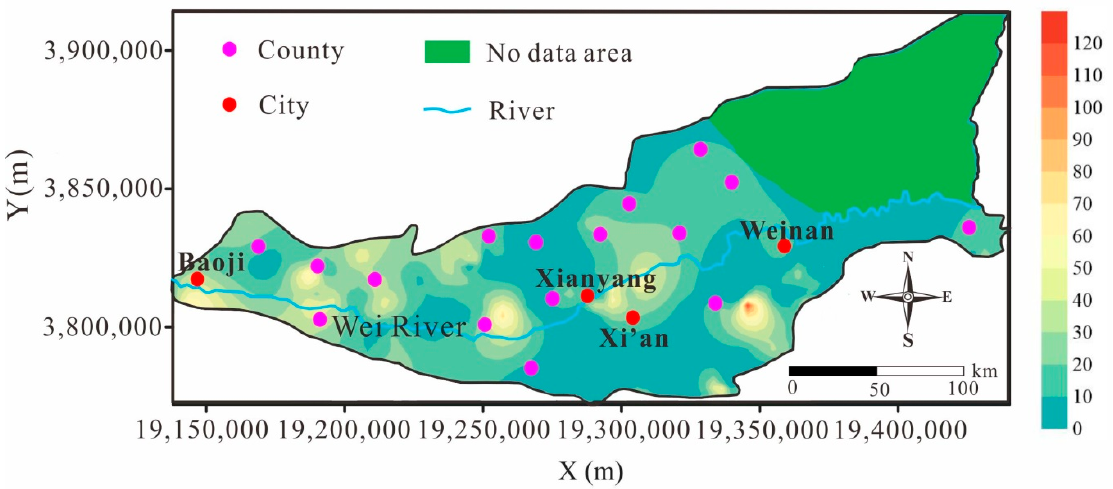
− in the Guanzhong Basin, 3